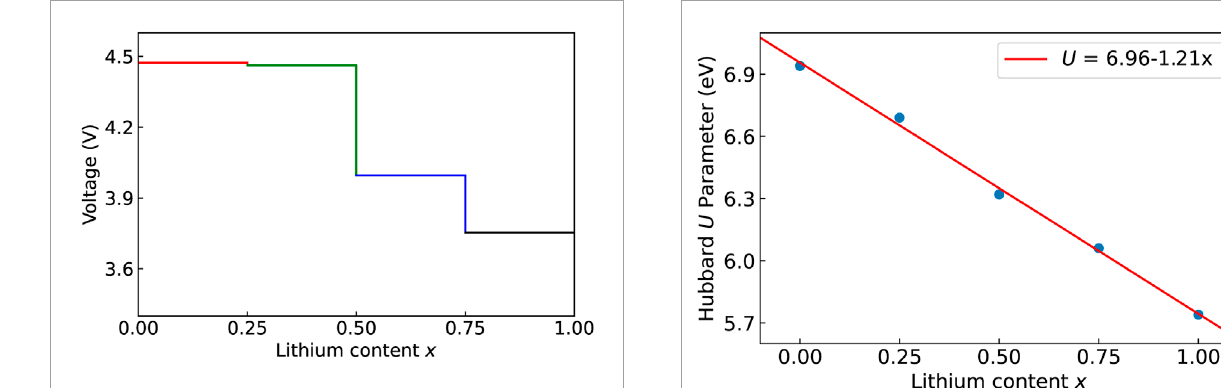
considered ( S = 205 J / mol / K at 293 K), the resulting free energy of formation is 50 . 31 , kJ / mol, is in good agreement with the measured value of 53 . 35 , kJ / mol (Wang and Navrotsky, 2004).